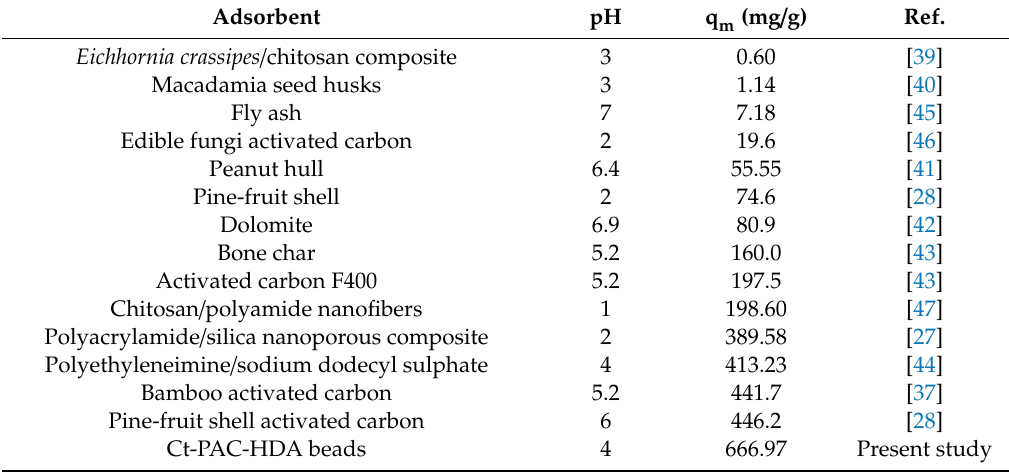
Table 3. Comparison of the maximum RB5 adsorption capacity of different adsorbents.